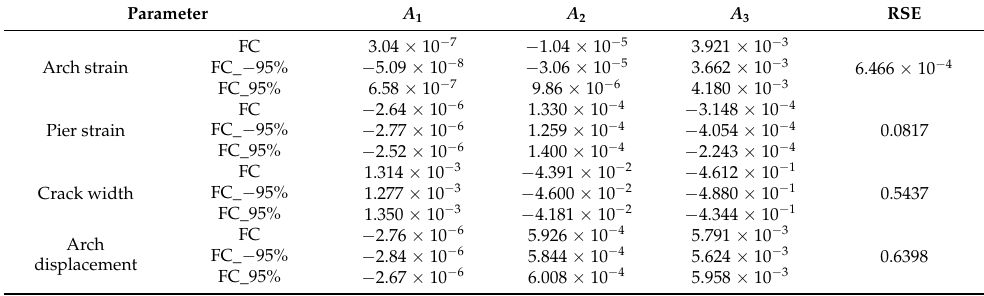
Table 11. Fitted regression coefficients and their coefficients with ± 95% confidence